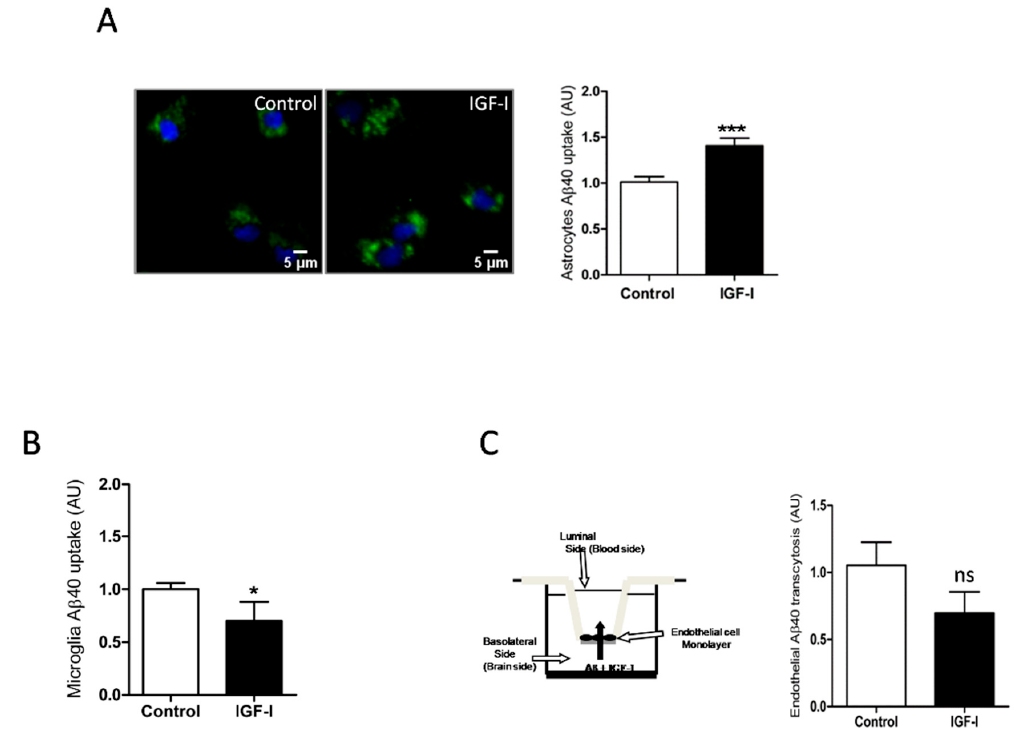
Figure 4. IGF-I modulates brain A β uptake in a cell-specific manner. ( A ) A β uptake by astrocytes is significantly increased by IGF-I ( n = 8). Representative photomicrograph showing uptake by cultured astrocytes of fluorescently labeled A β (green). Cell nuclei stained with Hoescht. ( B ) A β uptake by microglia is significantly reduced by IGF-I ( n = 7). ( C ) IGF-I did not significantly affect brain-to-blood efflux in an in vitro system mimicking the blood-brain-barrier (cartoon in the left). The amount of A β in the upper chamber was quantified 15 h after adding it to the lower chamber in the presence or absence of IGF-I ( n = 6). * p < 0.05, *** p < 0.001 and not-significant (ns).